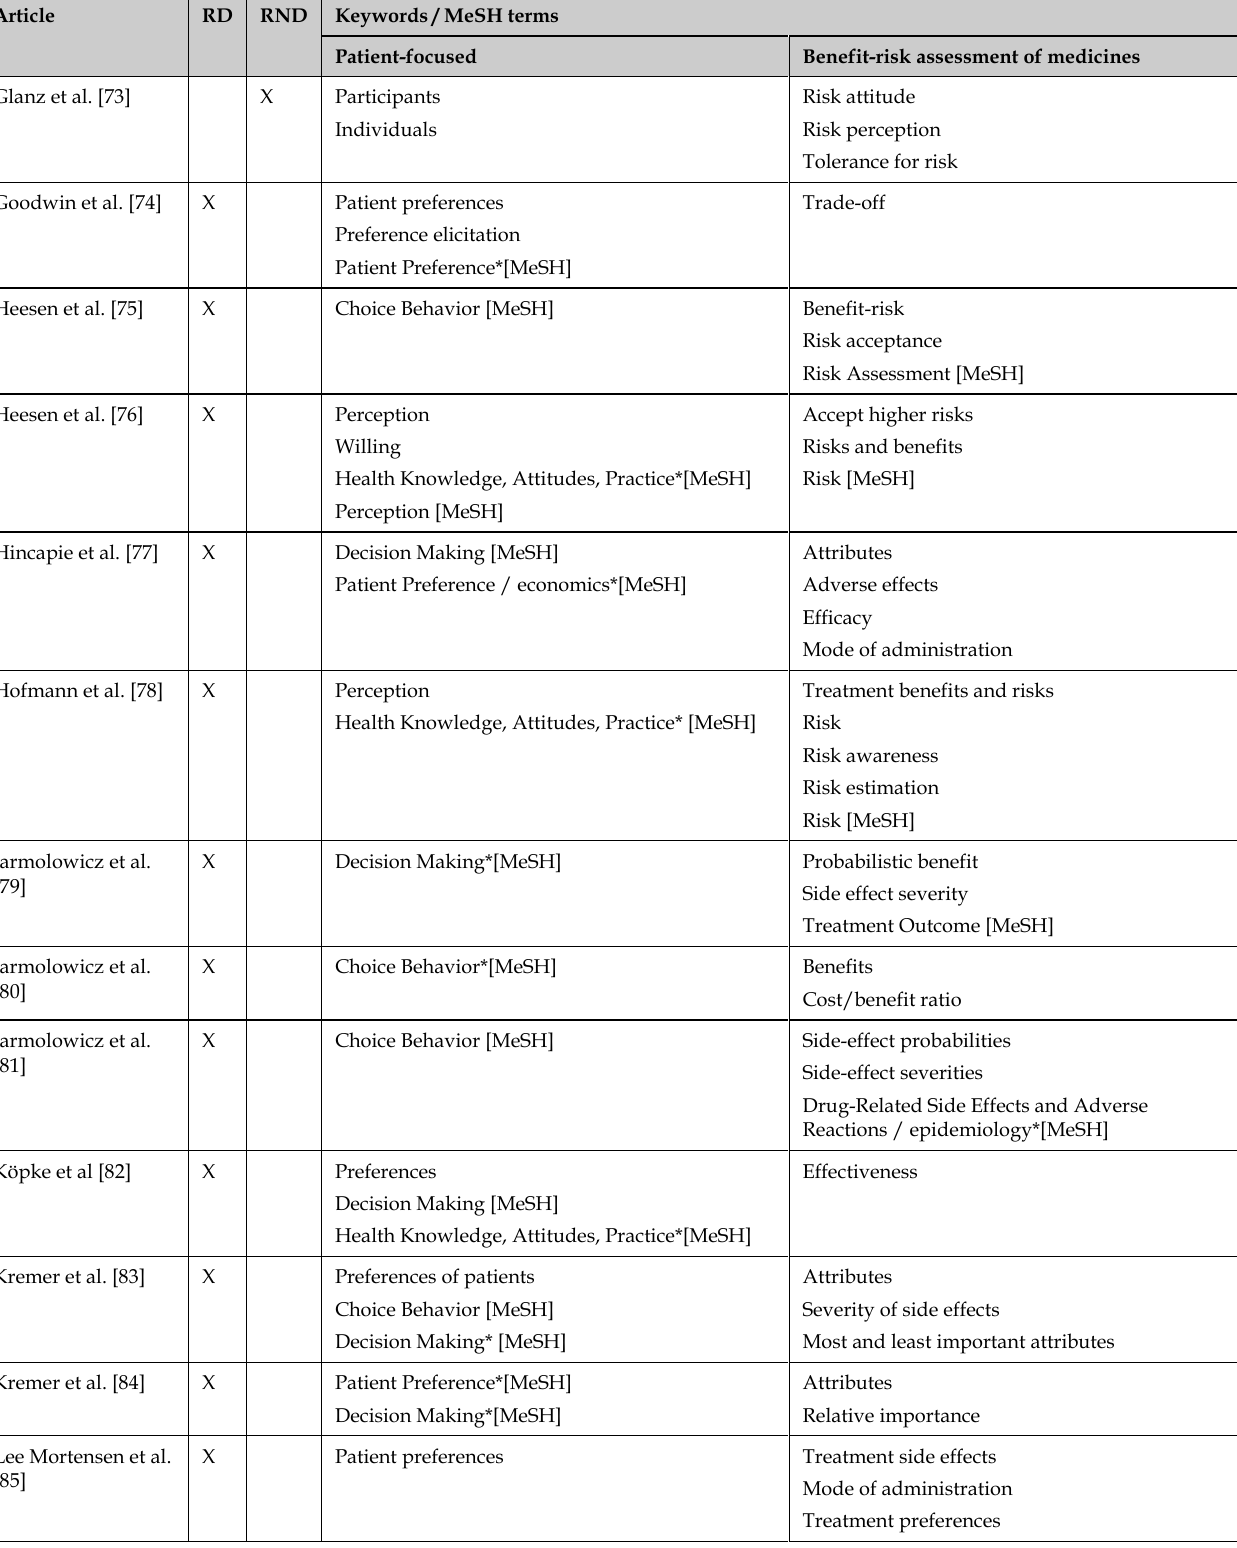
Table 3 Relevant articles on multiple sclerosis patients’ preferences regarding their medicines detected (RD) and not detected (RND) by the search strategy with corresponding keywords and MeSH terms